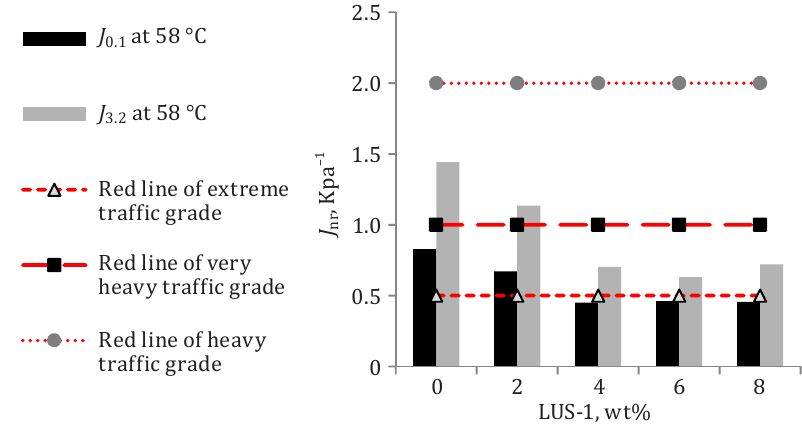
Figure 11. Effect of stress levels on non-recoverable creep compliance of asphalt binders at 58 °C